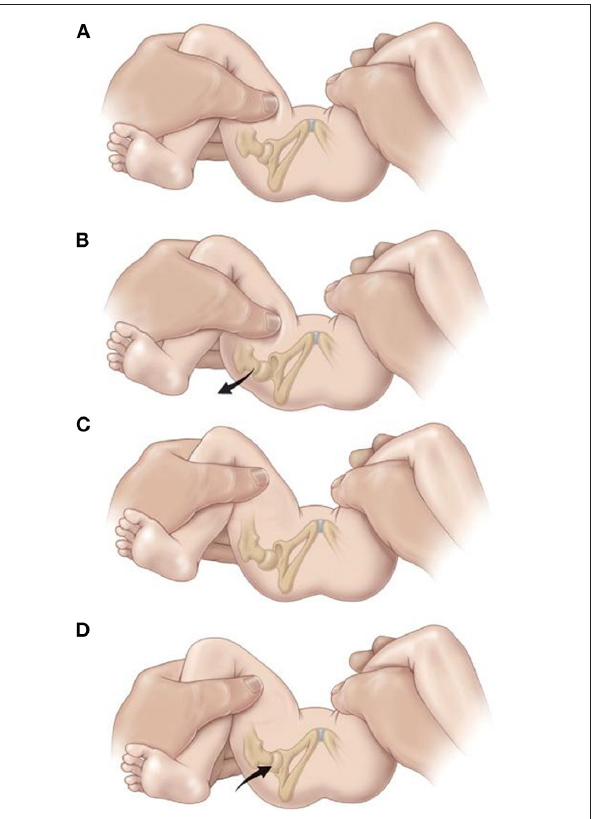
FIGURE 3 | The Barlow and Ortolani test in Humans. The Barlow test for developmental dislocation of the hip in a neonate. (A) With the infant supine, the examiner holds both of the child’s knees and gently adducts one hip and pushes posteriorly. (B) When the examination is positive, the examiner will feel the femoral head make a small jump (arrow) out of the acetabulum (Barlow’s sign). When the pressure is released, the head is felt to slip back into place The Ortolani test for developmental dislocation of the hip in a neonate. (C) The examiner holds the infant’s knees and gently abducts the hip while lifting up on the greater trochanter with two fingers. (D) When the test is positive, the dislocated femoral head will fall back into the acetabulum (arrow) with a palpable (but not audible) “clunk” as the hip is abducted. [Reprinted with permission from Tachdjian’s Pediatric Orthopedics (57), Elsevier